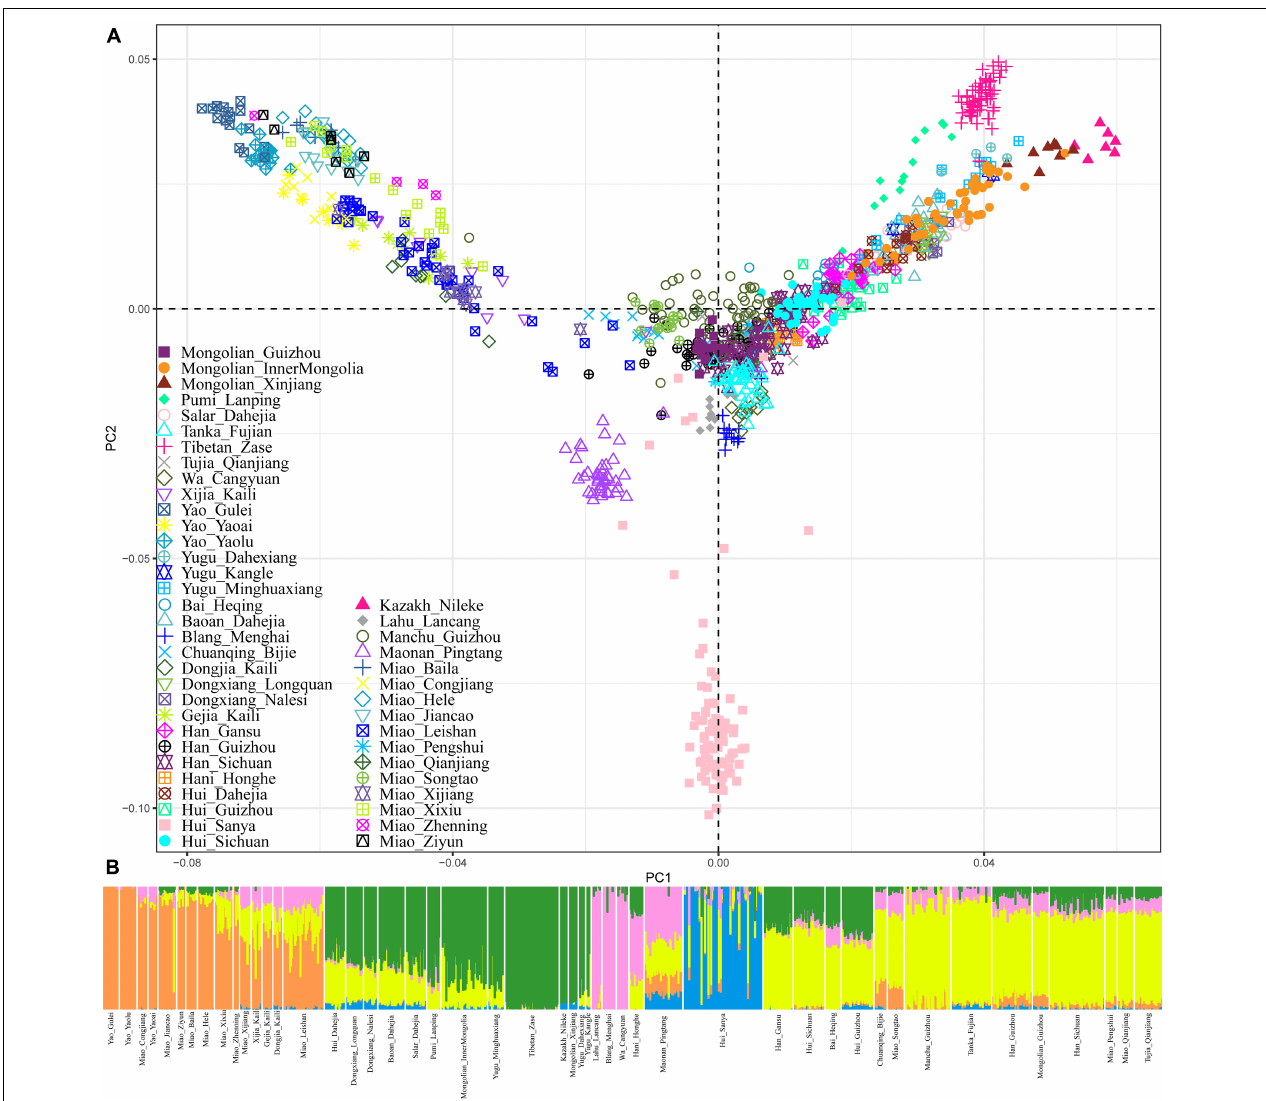
FIGURE 3 | Genetic structure among 1,049 individuals from 47 ethnolinguistically different populations. (A) Principal component analysis results based on the high-density SNP data (533,938 SNPs). (B) Model-based ADMIXTURE results with five predefined ancestral